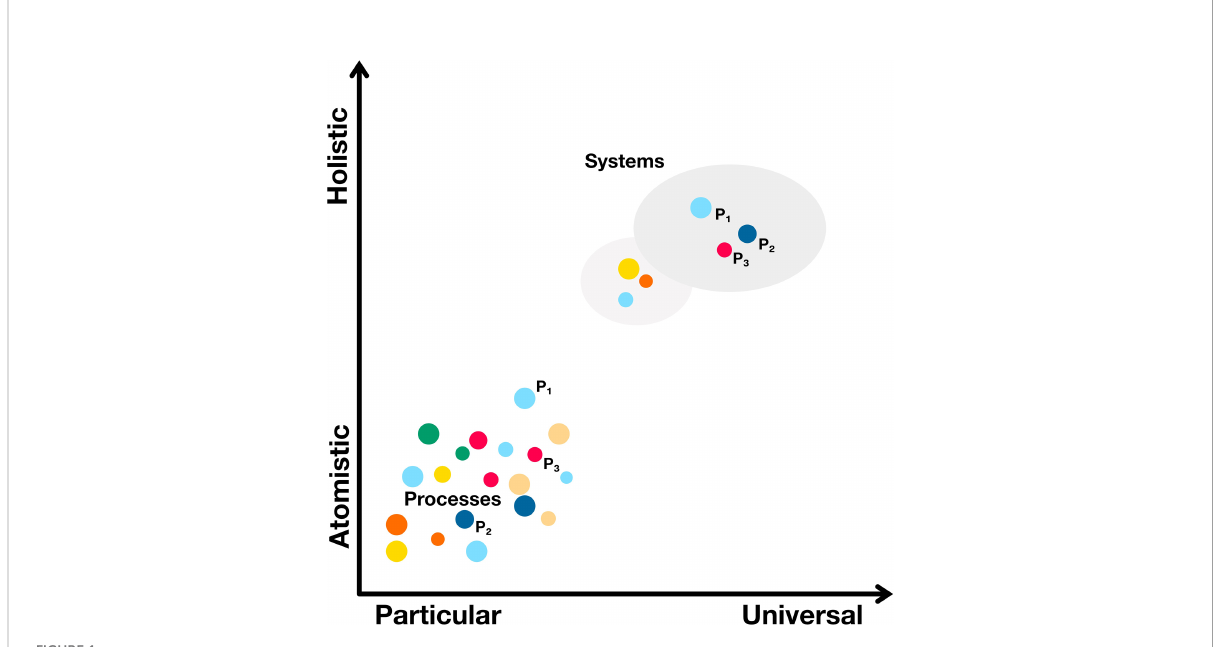
FIGURE 1 Sketch of the problem considered here, with circles indicating processes, some of which form parts of